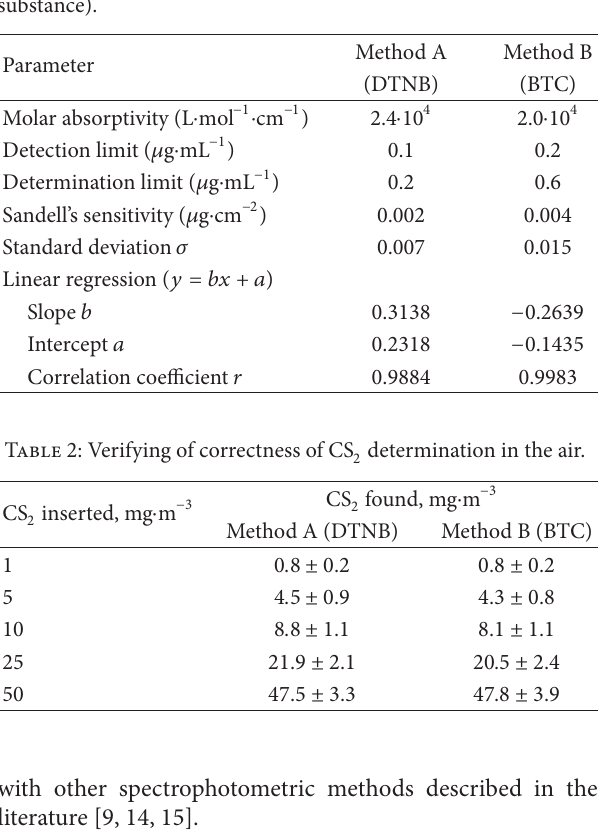
F 5: Calibration curves obtained for the determination of CS in the air by the DTNB method (1) and BTC method (2). T 1: Base parameters of CS substance).